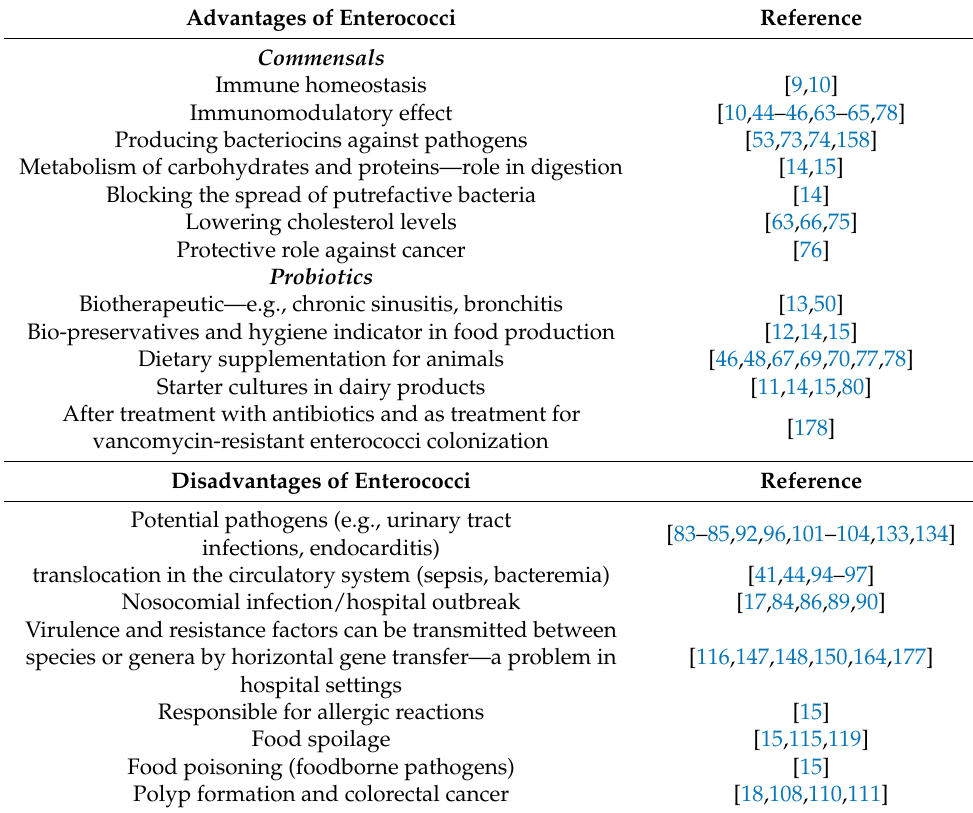
Table 1. Advantages and disadvantages of